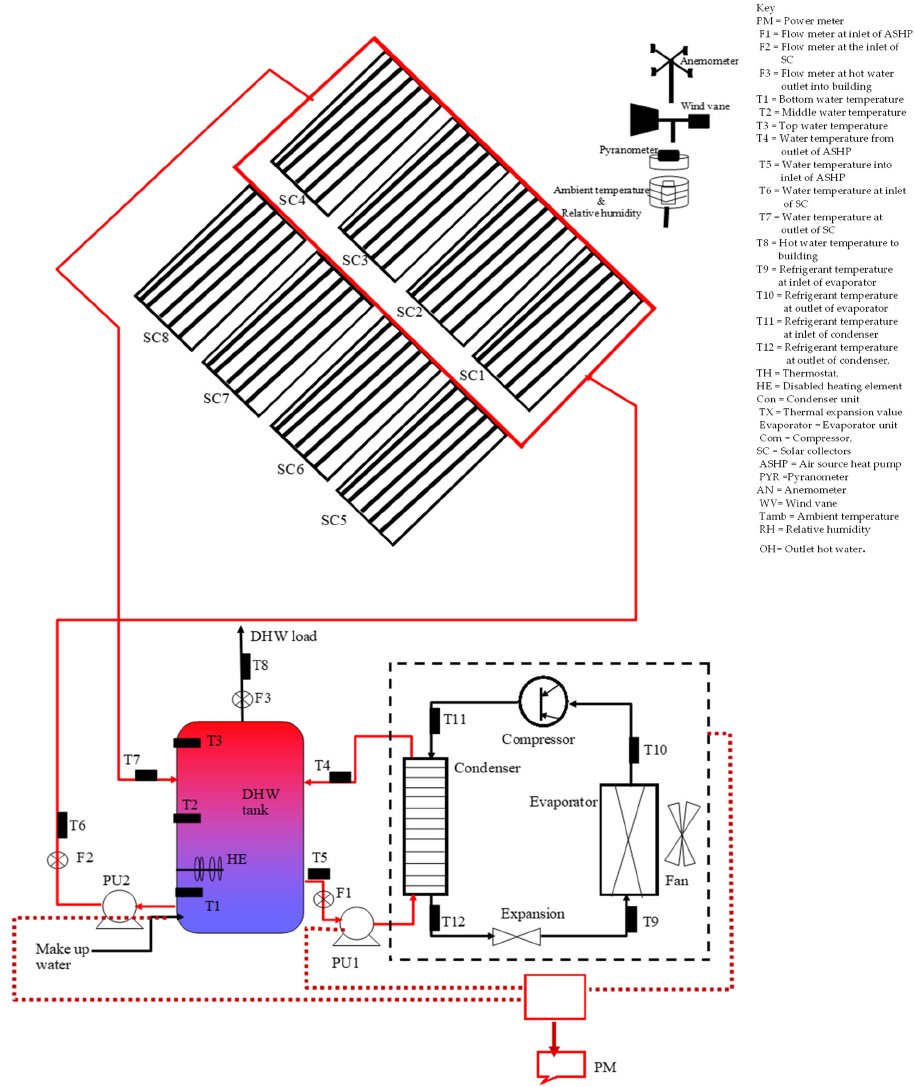
Figure 5. 2D schematic diagram of installed hybrid SAHP water heater and metering sensors.